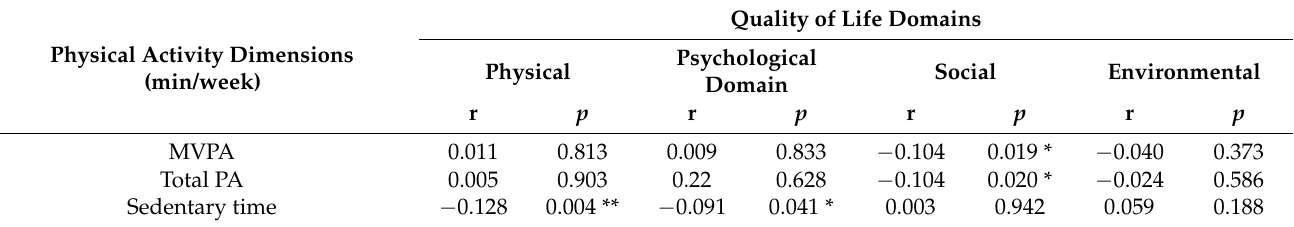
Table 4. Correlation between physical activity (measured with GPAQ) and quality of life (measured with WHOQoL-BREF) domains.